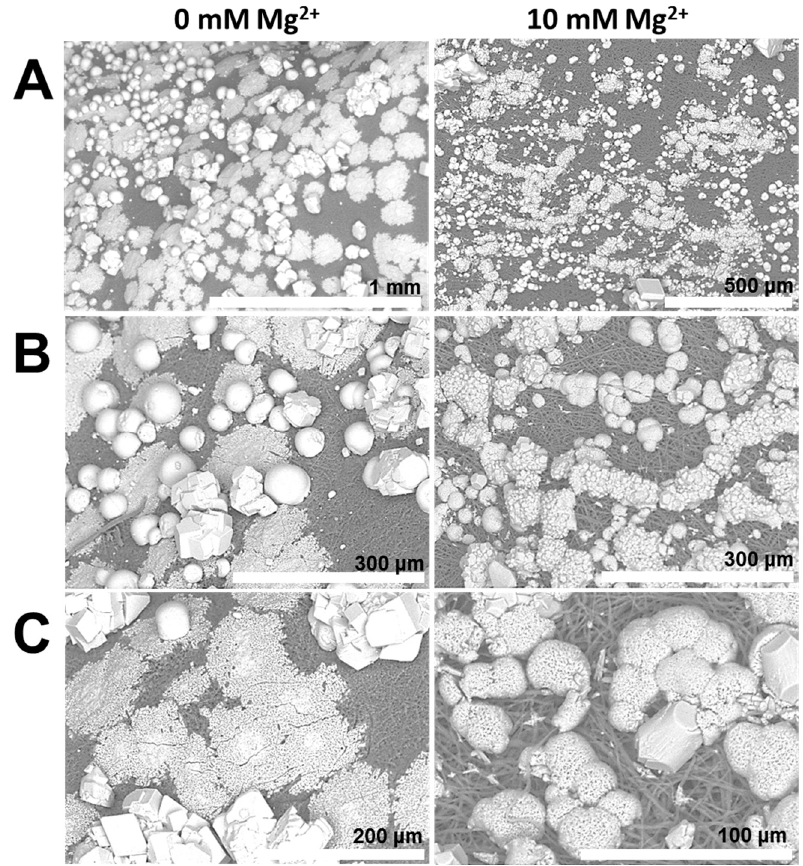
Figure 13. Representative SEM images of mineralized inner surfaces of egg shell membranes in the presence of poly(aspartic acid) (PASP) with ( right panel) and without ( left panel) Mg 2+ ions.